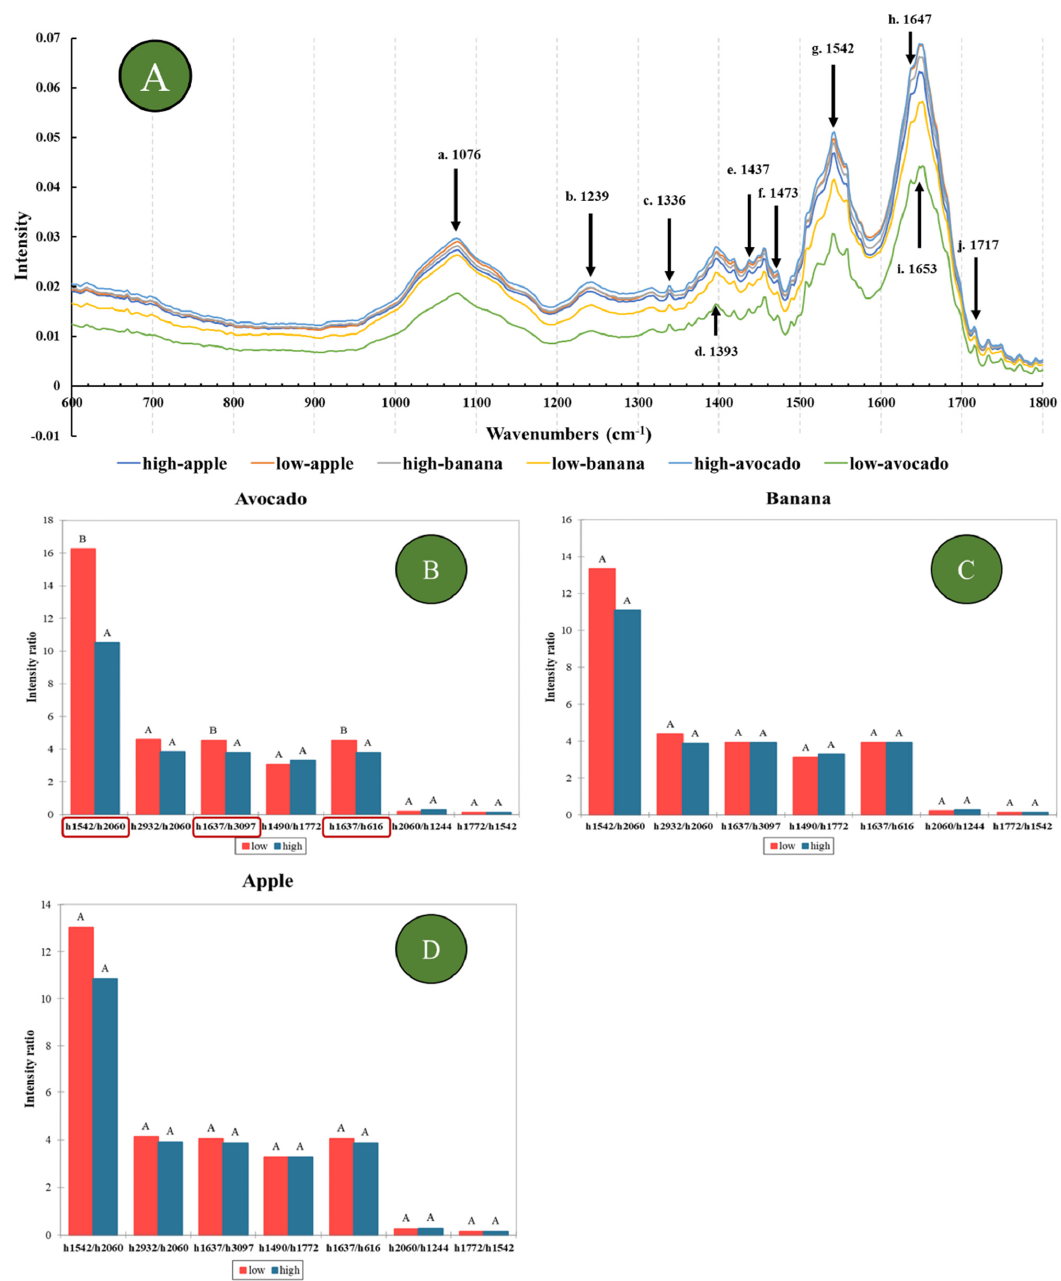
Figure 1. Mid-infrared spectra and ratios at specific frequencies of the unstimulated saliva samples analysed to show differences between low and high satiety groups. ( A ) Fingerprint region of salivary spectra comparing both food types and satiety perception types. The main reported absorption peaks in the literature [5,32,33,41–46] were labelled with lower case and wavelength number (a1076 cm − 1 , glycosylated proteins and phosphorus-containing components; b1239 cm − 1 , amide III/phospholipids; c1336 cm − 1 , carboxyl groups COO and asymmetric C-N stretching; d1393 cm − 1 , asymmetric and symmetric CH2 bending; e1437 cm − 1 , and f1473 cm − 1 , δ (CH 2 ) groups corresponding to biochemical indicators for triene conjugates and superoxide dismutase; g1542 cm − 1 , amide II ( δ NH, ν CN) groups; h1647 cm − 1 , amide I corresponding with albumin; i1653 cm − 1 , amide I proteins in α -helix; and j1717 cm − 1 , amide I purine bases, DNA and RNA). ( B ) Avocado, ( C ) banana, and ( D ) apple; ratios at specific frequencies calculated from the salivary spectra comparing the high and low satiety perceiver groups. The capital letters (e.g., A and B) in the figures signify significant difference between satiety perception